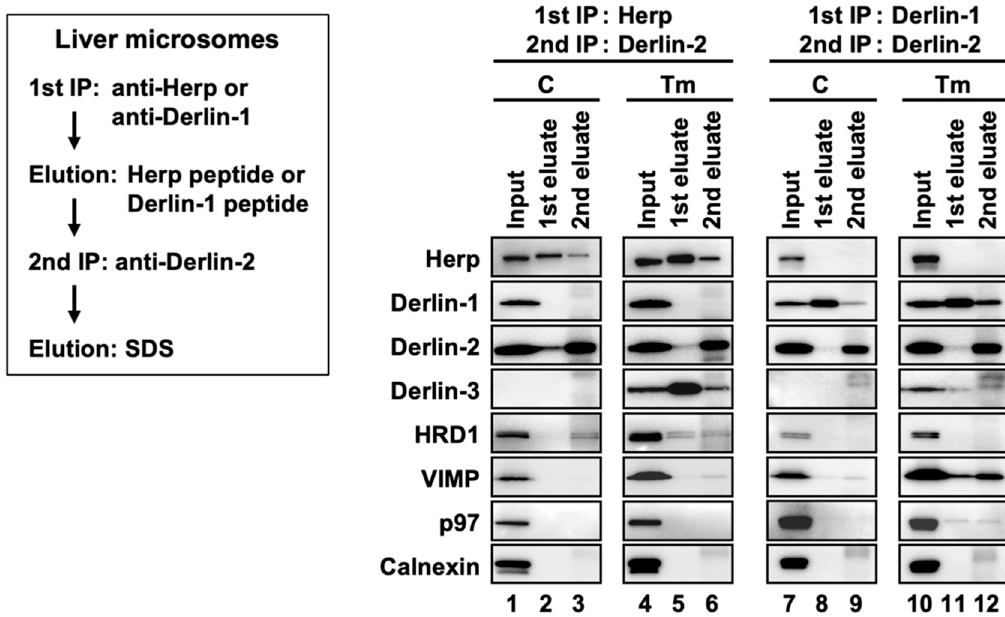
Figure 5. Sequential coimmunoprecipitation of ERAD factors. WT mice were injected intraperitoneally with PBS (C) or Tm 24 h before euthanasia. Digitonin-solubilized liver microsomes were prepared and subjected to sequential coimmunoprecipitation using anti-Herp (first) and anti-Derlin-2 (second) antibodies (left panels) or anti-Derlin-1 (first) and anti-Derlin-2 (second) antibodies (right panels). The eluates were analyzed by Western blotting using antibodies indicated on the left side. IP, immunoprecipitation.